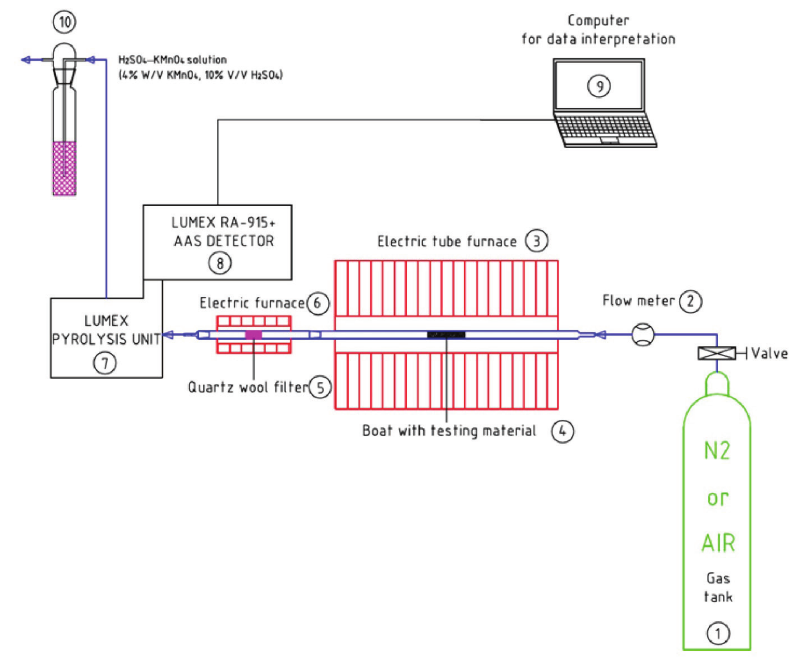
Figure 1: Scheme of the measuring